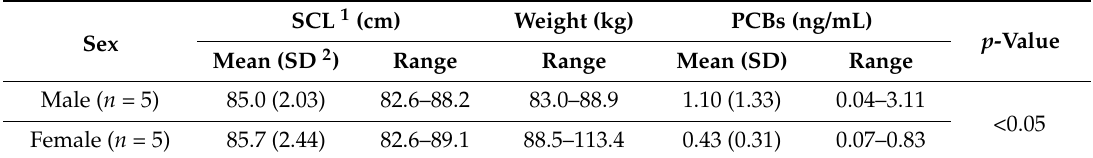
Table 1. PCBs concentration in plasma samples from healthy green turtle collected on Tern Island, Hawaii. SCL 1 (cm) Weight (kg) PCBs (ng/mL) Sex